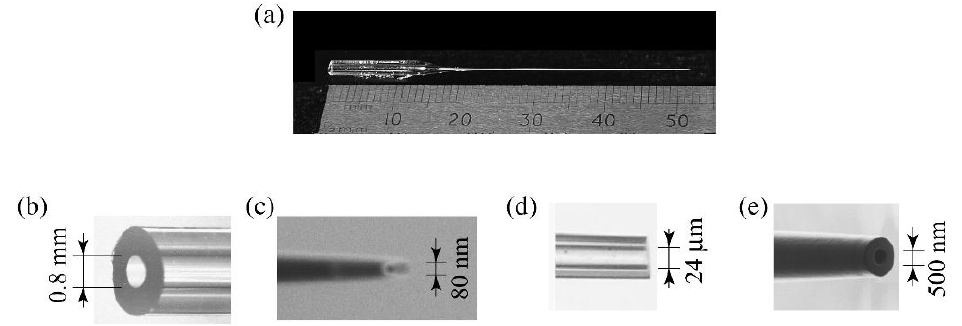
Figure 2. Photos of single tapered glass capillary optics: ( a ) whole glass capillary; ( b ) beam inlet; ( c ) outlet of the smallest level; and ( d , e ) outlet after cutting (from [10], Copyright 2011, with permission from Elsevier).